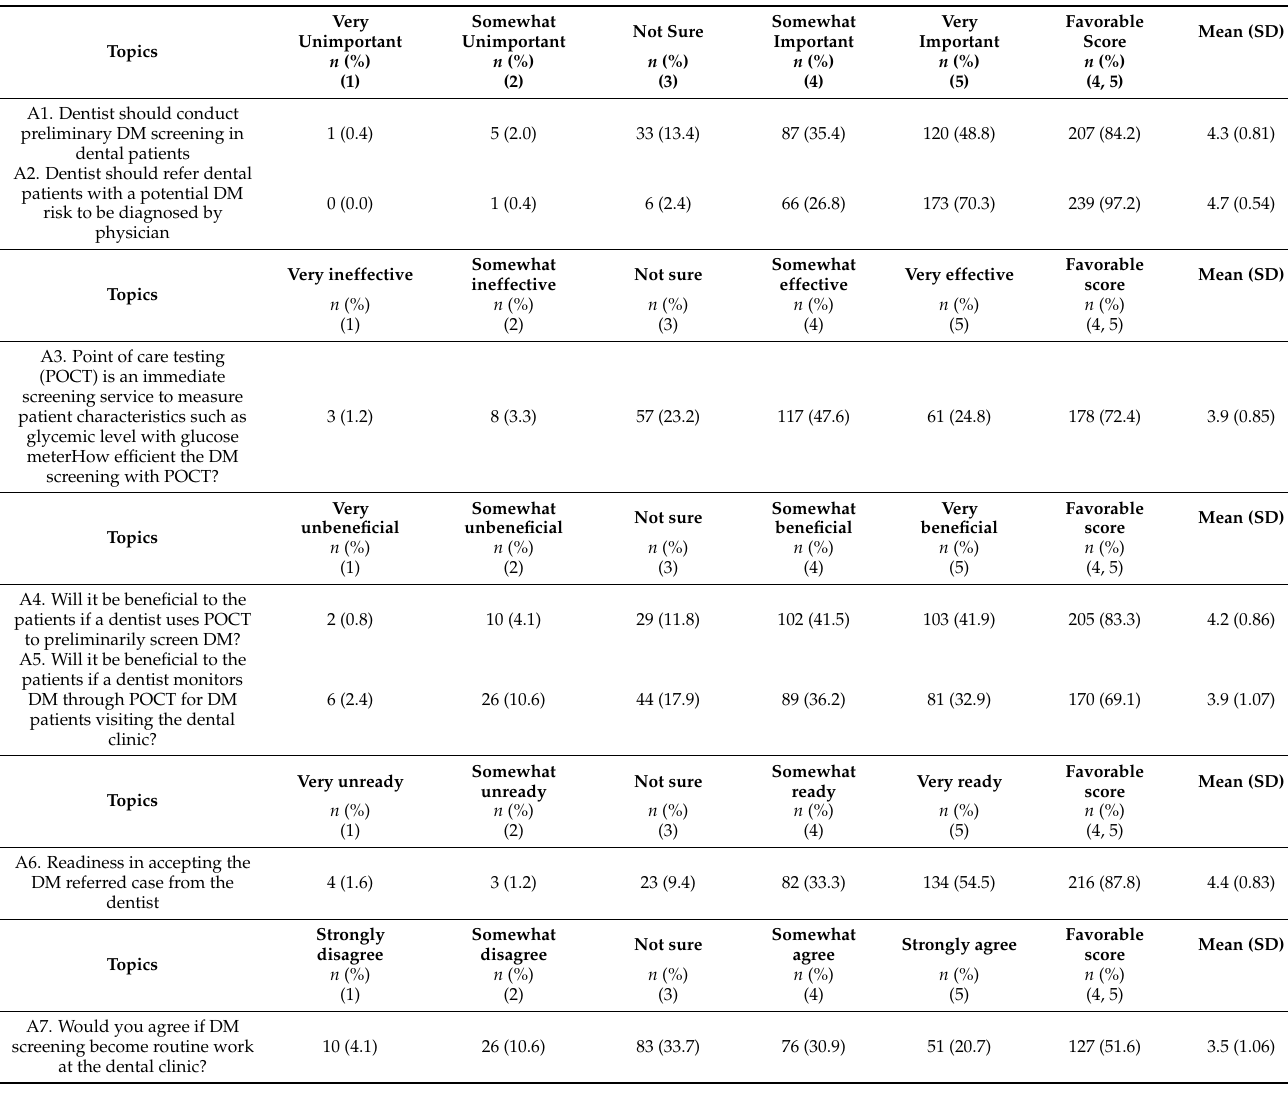
Table 4. Attitude of medical doctor who provide correct answer in the knowledge session towards diabetes screening in dental clinic ( n =